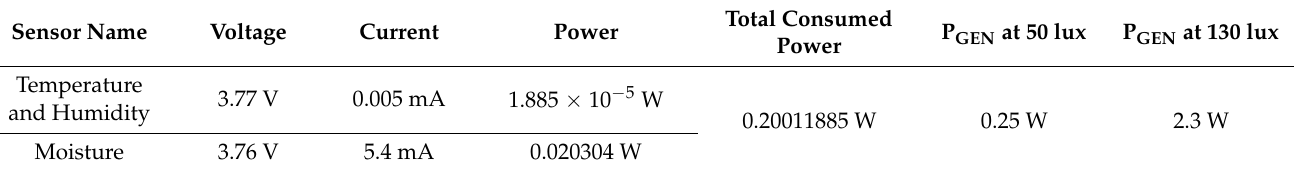
Table 2. Measurements of the generated power (P GEN ) and consumed